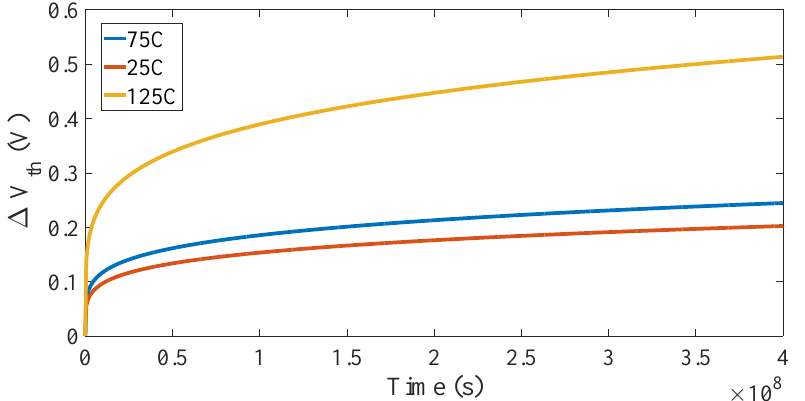
Figure 12. PBTI model results compared to the measured data for the InGaAs to Al 2 O 3 interface.